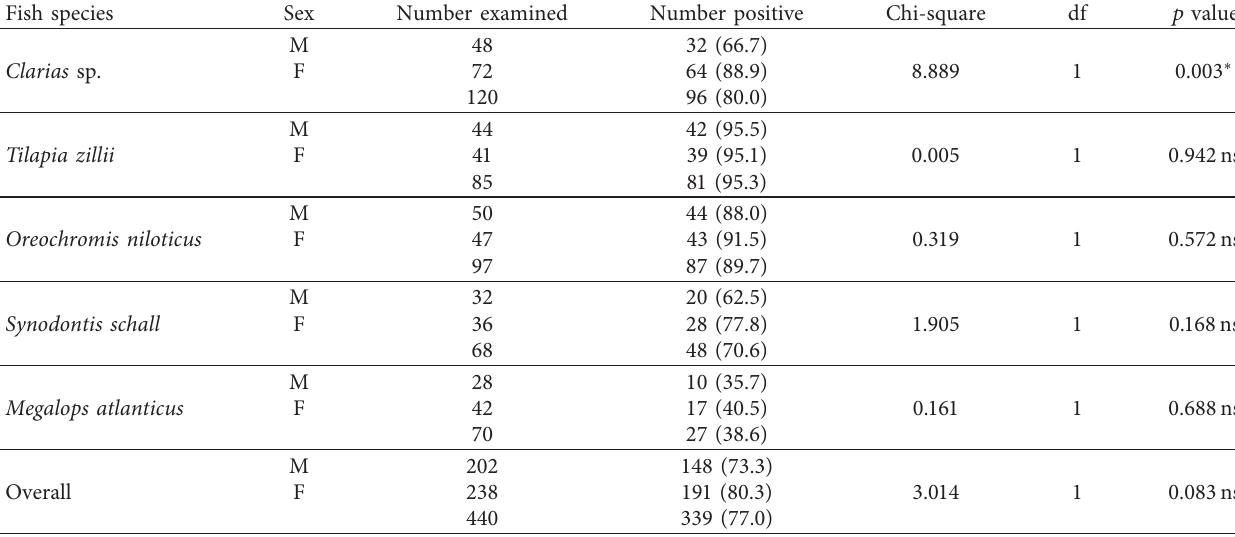
Table 4: Sex-specific prevalence of parasites in fish species in rivers Niger and Benue at Lokoja.